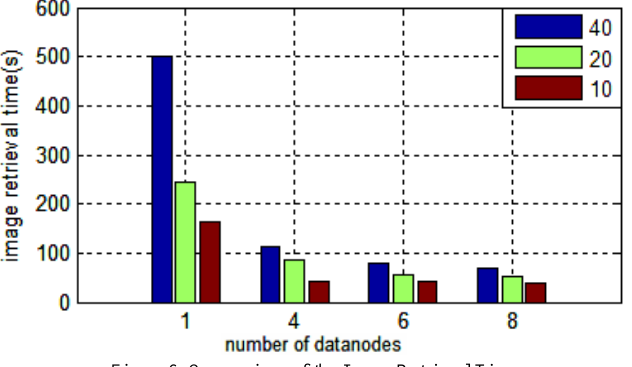
Figure 6. Comparison of the Image Retrieval Time